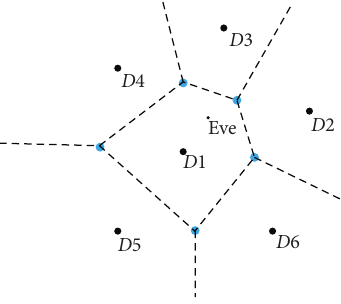
Figure 2: Block D in the Dirichlet